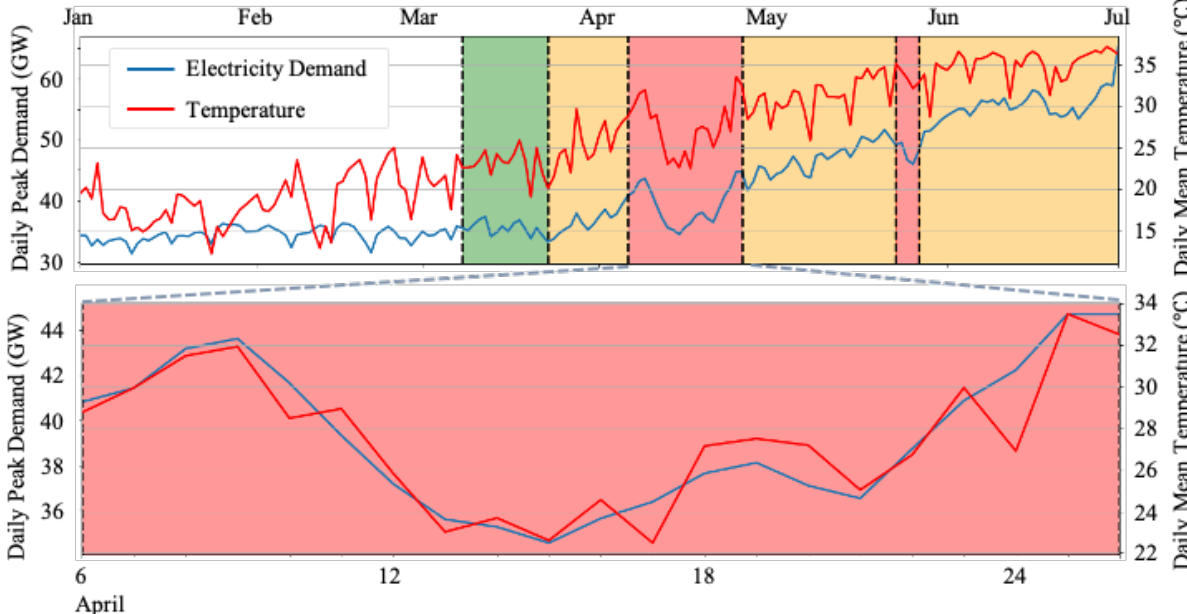
Figure 3. Daily electricity demand and ambient temperature from 1 January 2020, to 1 July 2020, before and during the imposed social distancing policies, and a zoom-in from 6–26 April 2020, during full